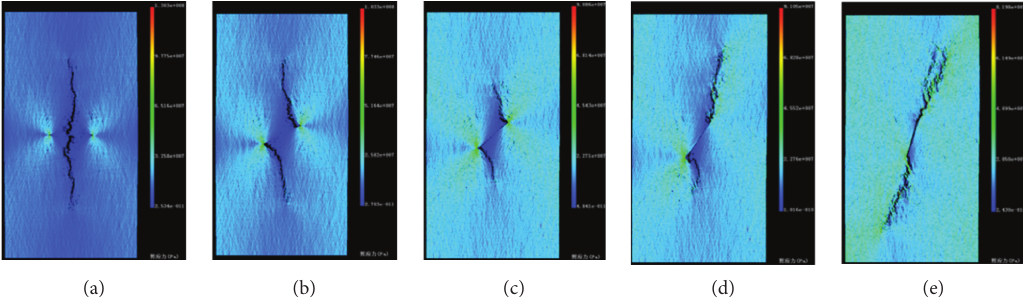
Figure 9: Failure patterns of rock specimens with different inclination angles of preexisting cracks under static loading. (a) α � 0 ° . (b) α � 30 °